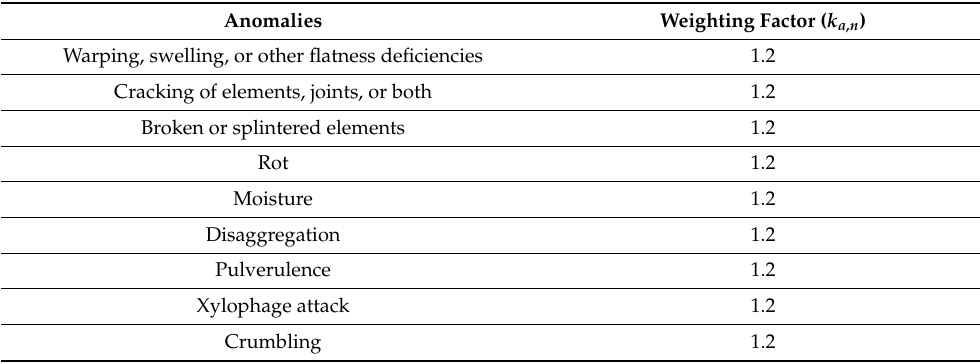
Table 4. Weighting factors associated to functional